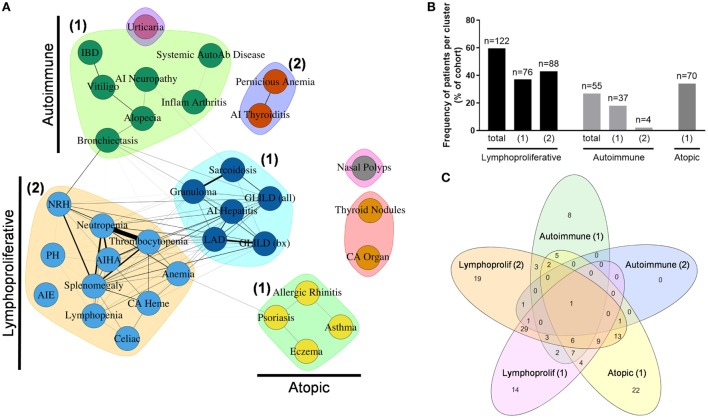
Unbiased network clustering of non-infectious disease complications in the Partners cohort. (A) Graph of inter-relationship among 34 non-infectious disease complications in the Partners cohort defined using unbiased network clustering. Nodes in the graph represent disease complications; links between nodes denote statistically significant relations between comorbidities; clustering of comorbidities represents disease patterns with high likelihood of co-occurrence as defined by the Girvan–Newman clustering algorithm (20). The weight of each network link correlates with the strength of the association between two comorbidities, as measured by chi-square test (P < 0.05). Nodes in isolation indicate disease complications that failed to cluster due to a lack of association with other comorbidities. Subgraphs are annotated as lymphoproliferative (1 and 2), autoimmune (1 and 2), and atopic (1) clusters, respectively. (B) Patient assignment by non-infectious disease cluster, shown as percentage of total cohort. (C) Cluster overlap, shown as a Venn diagram assembled using the web-based tool InteractiVenn as previously described (43). AI, autoimmune; AIE, autoimmune enteropathy; AIHA, autoimmune hemolytic anemia; autoab, auto-antibody; bx, biopsy-proven; CA heme, hematologic cancers; CA organ, solid organ cancers; chronic intermittent urticaria (urticaria); GLILD, granulomatous-interstitial lung disease; IBD, inflammatory bowel disease; LAD, lymphadenopathy; NRH, nodular regenerative hyperplasia; PH, pulmonary hypertension.